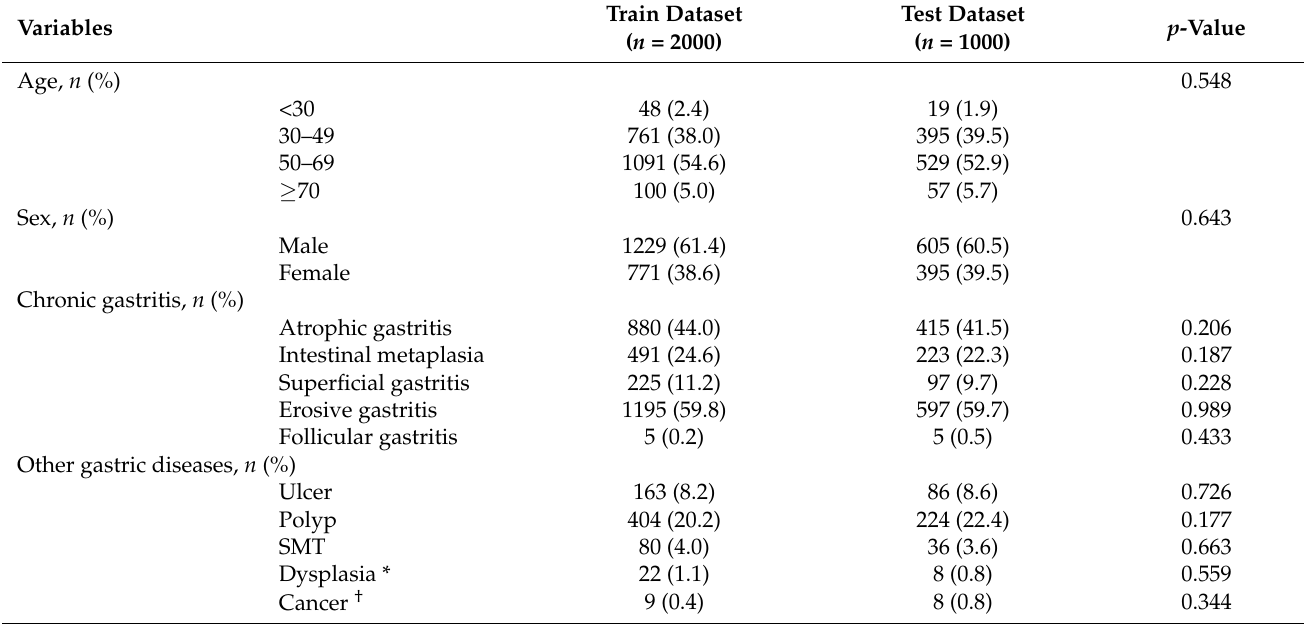
Table 1. Demographics of the train dataset ( n = 2000) and test dataset ( n =